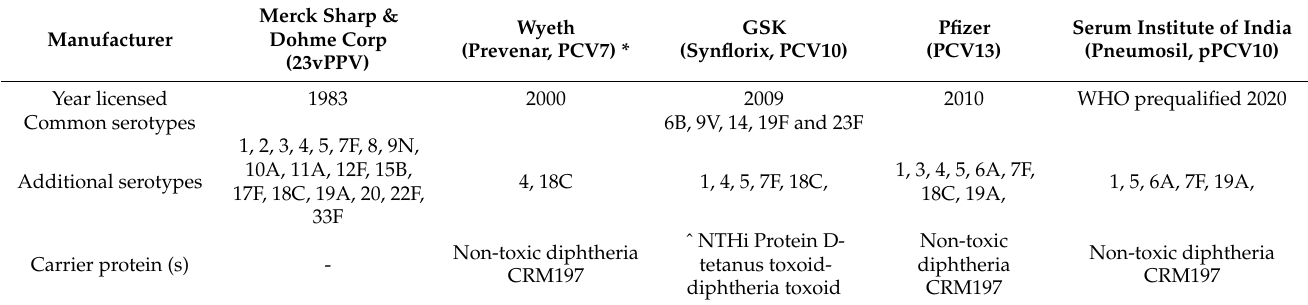
Table 1. Pneumococcal